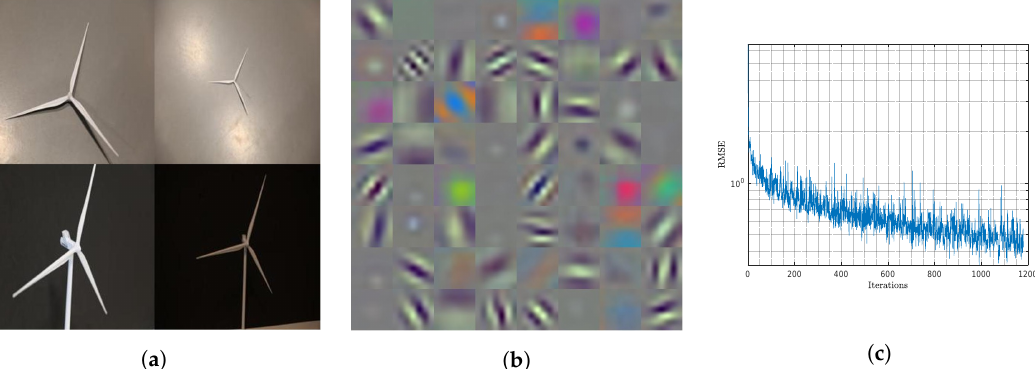
Figure 1. Partial output of feature extraction sub-network, examples of training images and training results. ( a ) Training images of wind turbines; ( b ) Output feature maps of 2nd layer; ( c ) RMSE when training for 10 epochs and 1180 iterations.